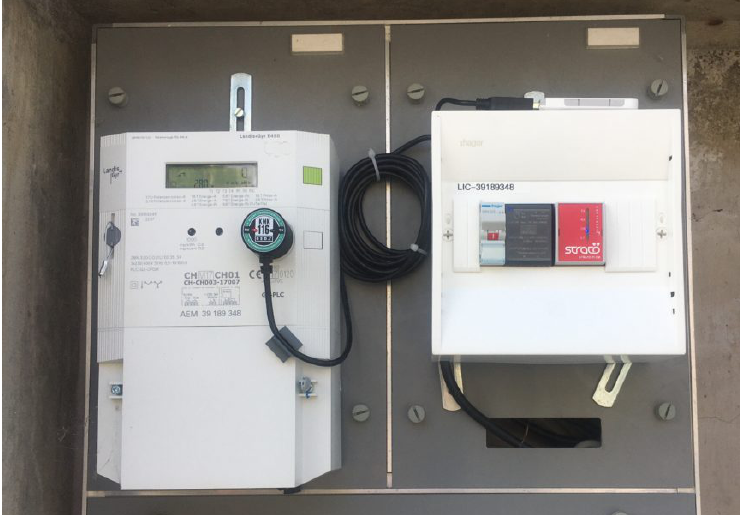
Figure 2. Strato Pi CM ( right ), USB 4G connection dongle (on the case of the Strato Pi CM) and smart meter ( left ) with optical reading probe, installed at a point of